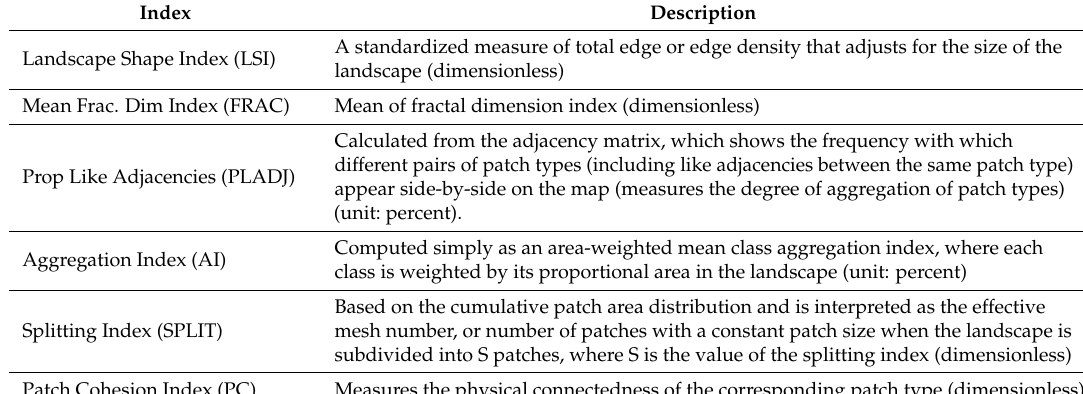
Table 2. Landscape metrics description (From [56]). More information about how the indices are calculated can be found at Appendix